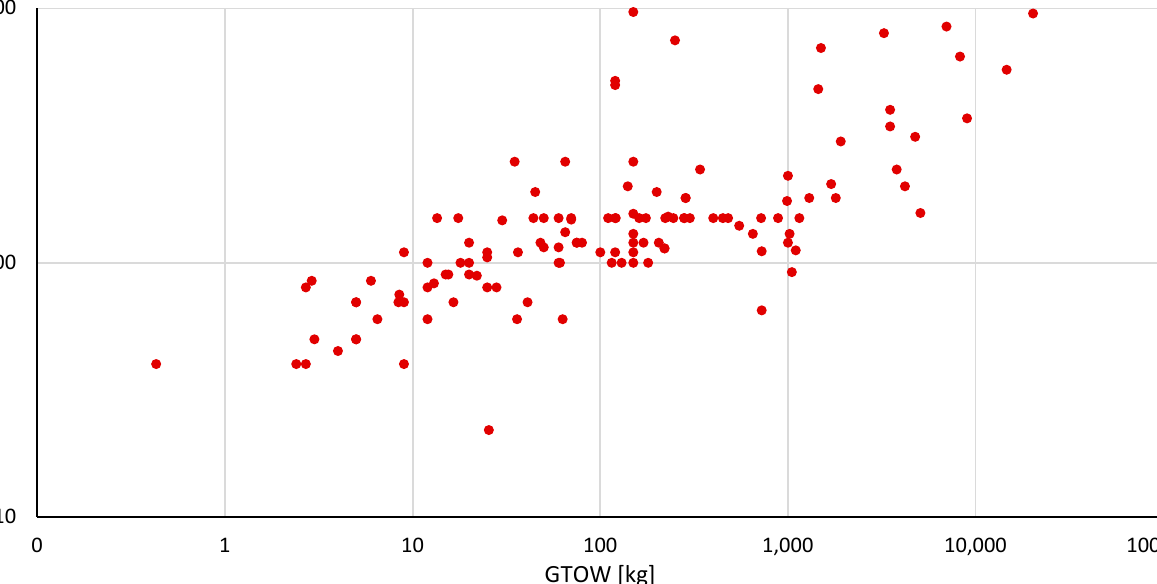
Figure 20. Cruise speed as a function of GTOW for the general category.